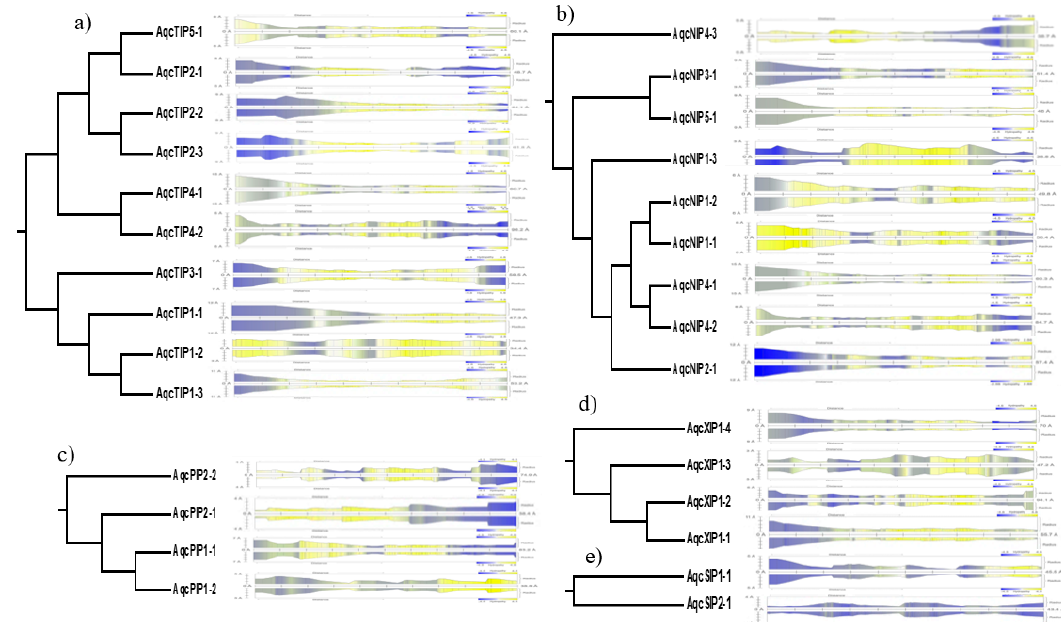
Figure 5. Predicted pore structure and hydropathy analysis of different subgroups: ( a ) tonoplast intrinsic proteins (TIPs); ( b ) nodulin 26-like intrinsic proteins (NIPs); ( c ) plasma membrane intrinsic proteins (PIP); ( d ) uncharacterized intrinsic proteins (XIPs); and ( e ) small intrinsic proteins (SIPs) in Aquilegia . In the given hydropathy plot, blue signifies the hydrophilic nature of the pore, and yellow signifies the hydrophobic nature of the pore.